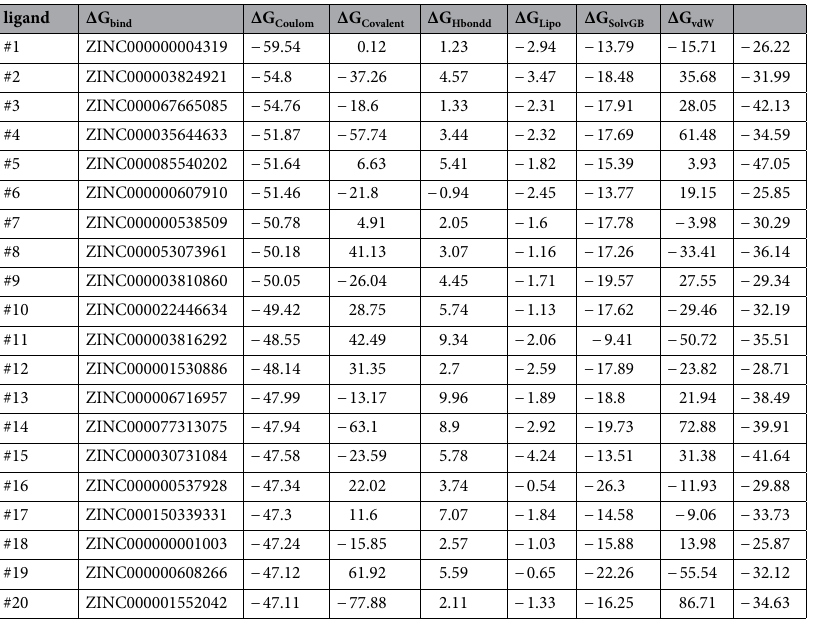
Table 2. Binding energy (kcal/mol) and individual energy terms of Delta RBD-ligand systems calculated by Prime